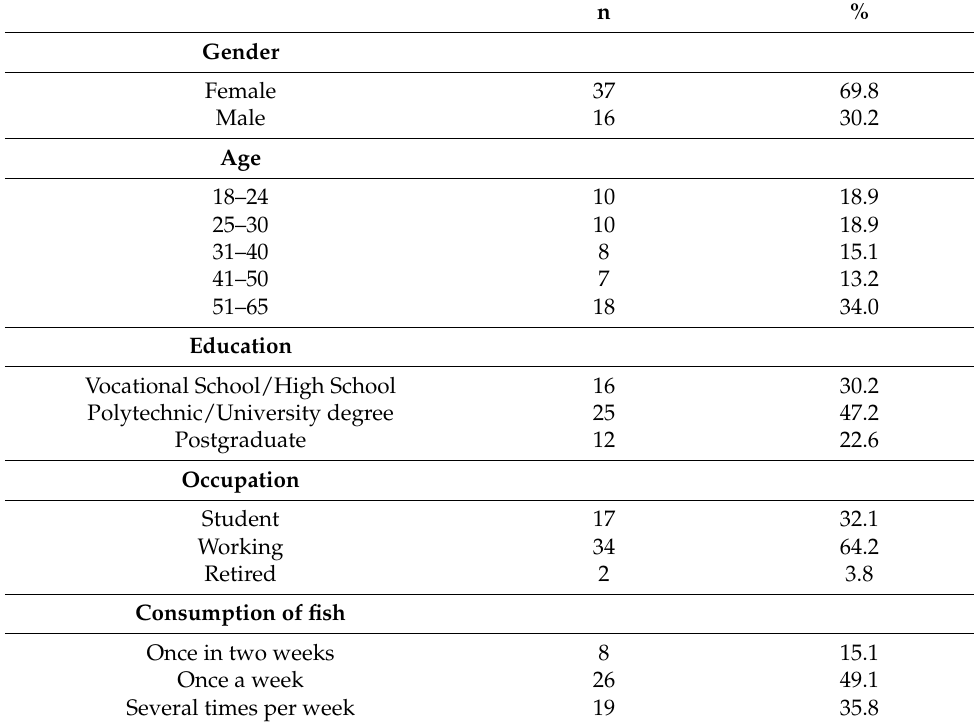
Table A1. Background information of the consumers (n =